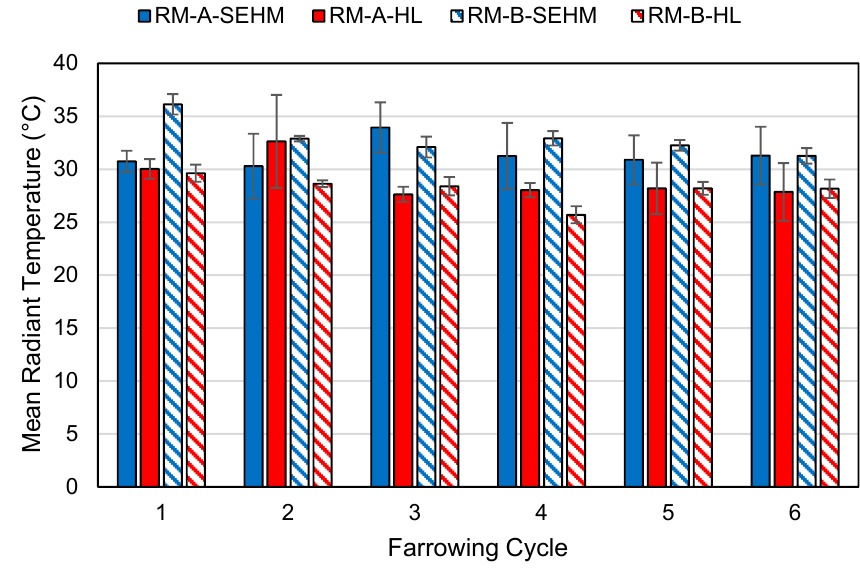
Figure 6. Average dry-bulb temperature of the creep area microclimate by heat source and room macroclimate (A and B) by farrowing cycle. Error bars represent one standard deviation of the mean.